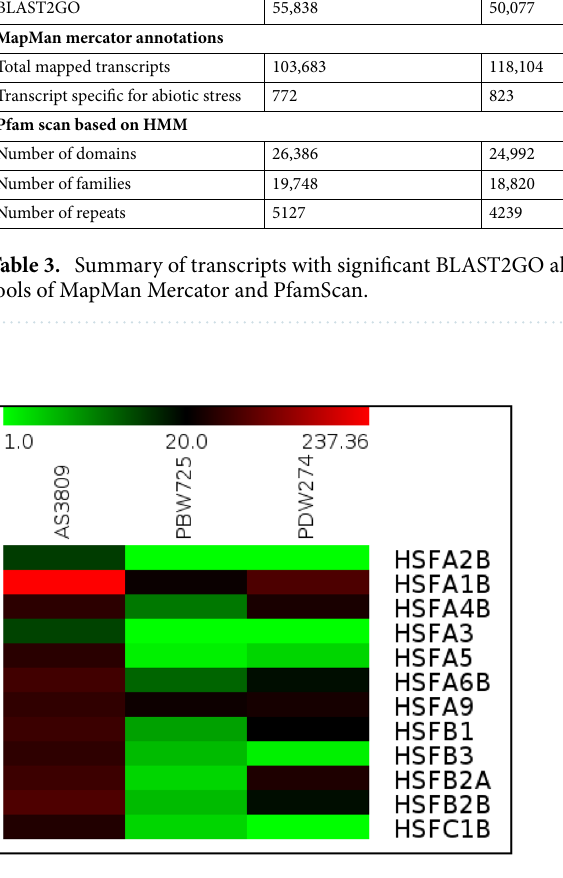
Figure 2. Heat map representing the different classes of HSF transcripts having a similar function in AS3809, PBW725, and PDW274 (red: maximum expression, black: median, green: minimum